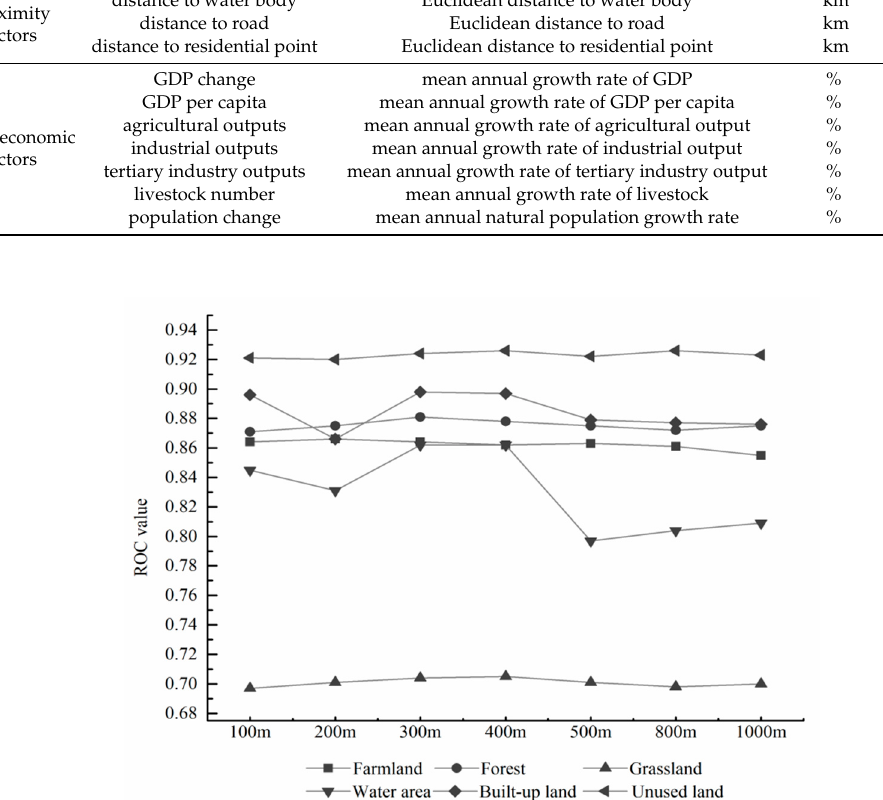
Figure 4. ROC value of each land use type in different modeling scales.